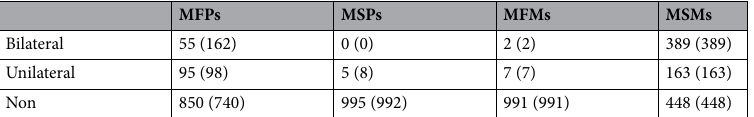
Table 5. The symmetry of CSRCs (RGs) in different tooth positions. CSRCs: C-shaped root canals, RGs: radicular grooves, MFPs: mandibular first premolars, MSPs: mandibular second premolars, MFMs: mandibular first molars, MSMs: mandibular second molars.